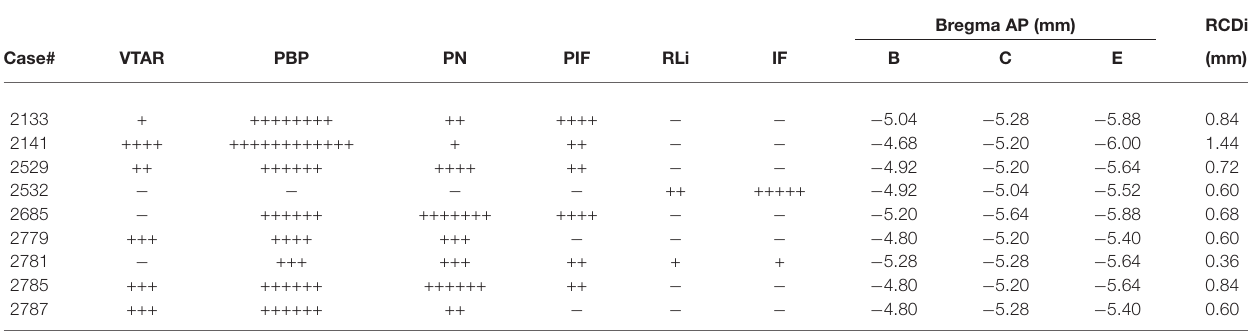
TABLE 1 | Characterization of the rostro-caudal spread of the different injection sites.